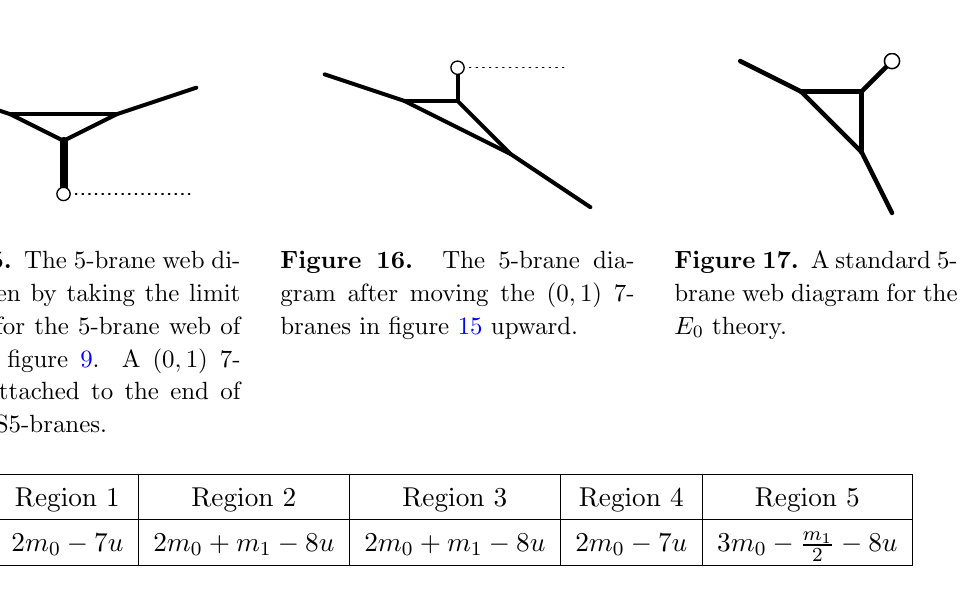
Table 7. The e(cid:11)ective coupling of the E 2 theory ( m 1 Rergion 6 Region 7 Region 8 Region 9 Region 10